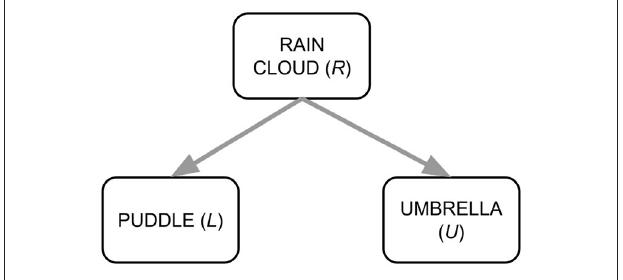
FIGURE 2 | Example